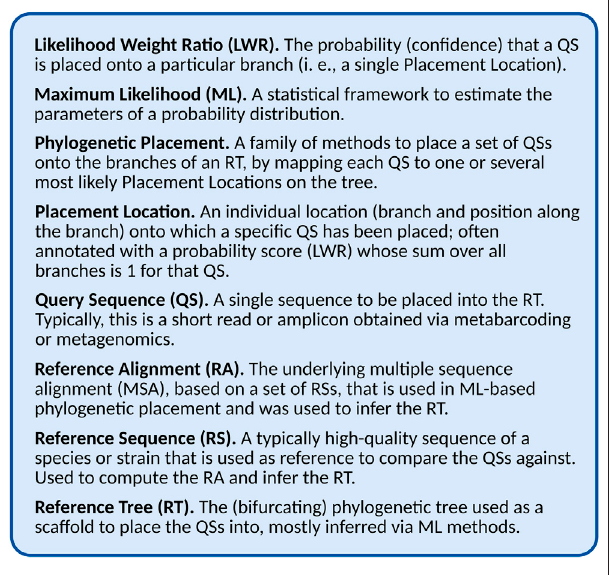
FIGURE 1 | Glossary and abbreviations.